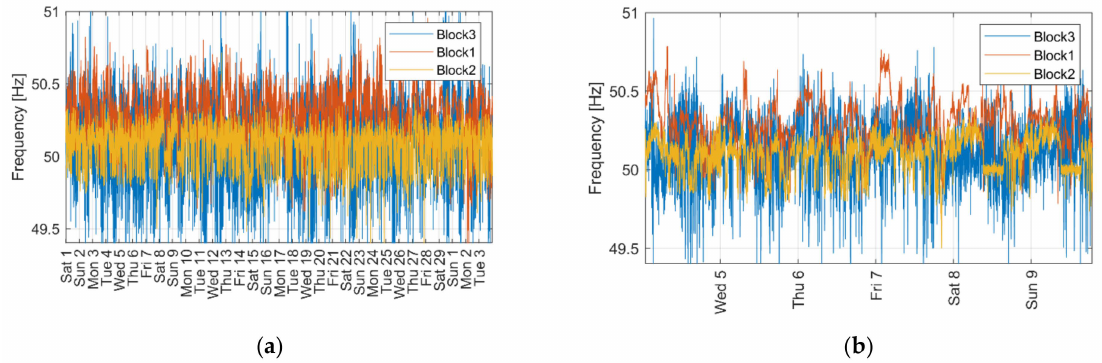
Figure 2. The frequency profiles of the three blocks. ( a ) one month frequency profile ( b ) 5 days frequency